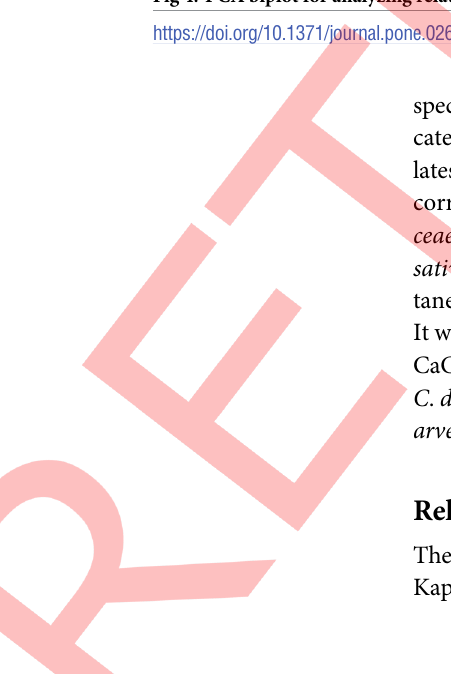
Fig 4. PCA biplot for analyzing relationship between weed communities’ frequency in different wheat